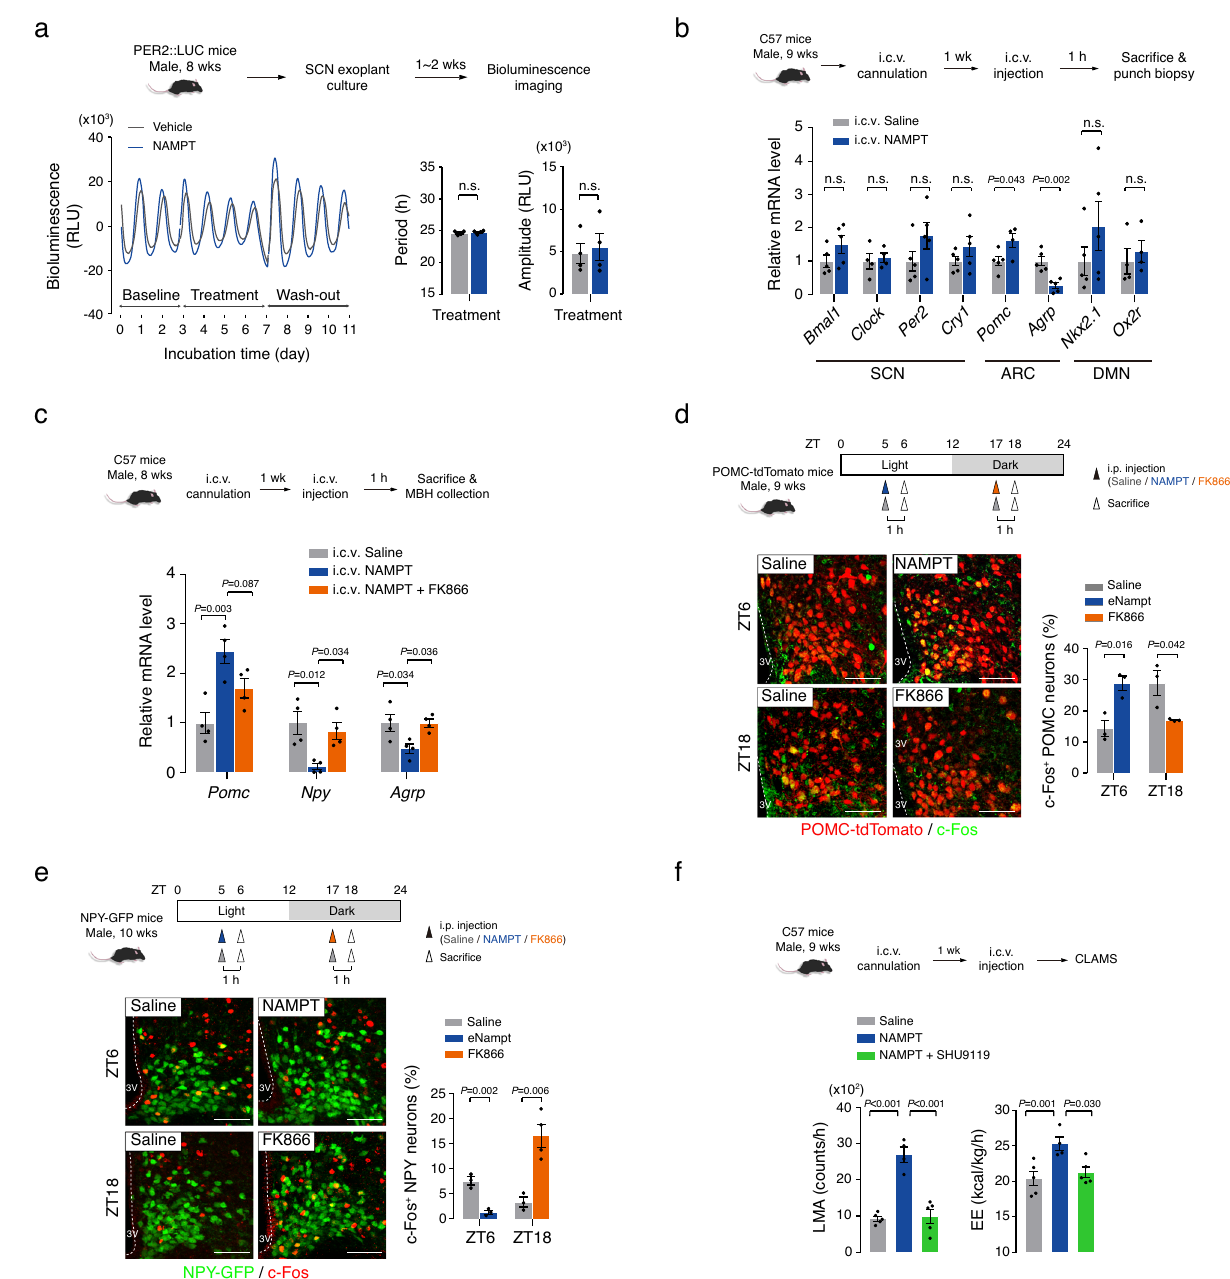
Fig. 4 | Systemic eNAMPT activity regulates hypothalamic POMC and NPY/ AGRP neurons. a Effects of NAMPT treatment on the SCN clock activity in SCN organotypic slice cultures obtained from PER2:LUC mice. SCN clock activity was determined by bioluminescence monitoring of PER2:luciferase activity. Repre- sentative circadian fl uctuation curve are presented. The average values of period and amplitude of fl uctuations were compared and plotted ( n =4 brain slices). One brain slice was obtained from one mice. Unpaired t -test (two-sided). n.s.: not sig- ni fi cant. b Effects of intracerebroventricular (i.c.v.) administration of NAMPT pro- tein (100ng) on hypothalamic mRNA levels of genes. NAMPT was administered at ZT5, which was1h before sacri fi ce (C lock, Pomc NAMPT, Ox2r , n =4; other groups, n =5 mice). Unpaired t -test (two-sided). n.s.: not signi fi cant. SCN: suprachiasmatic nucleus, ARC: arcuate nucleus, DMN: dorsomedial nucleus. c Inhibition of the